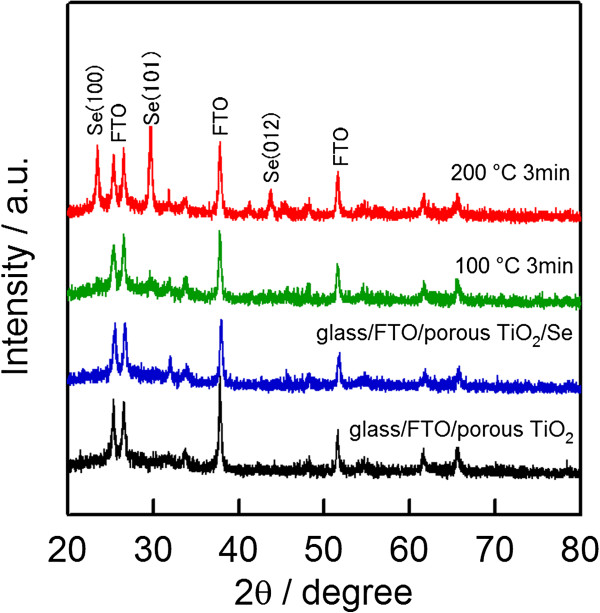
The XRD patterns of porous TiO2/compact TiO2/FTO with/without Se electrochemical deposition and with/without annealing.